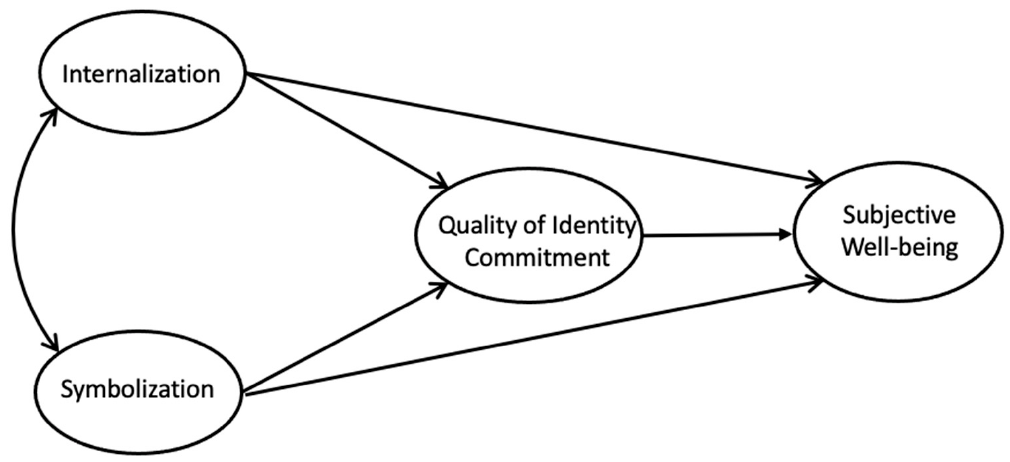
Figure 1. The assumed mediation model.